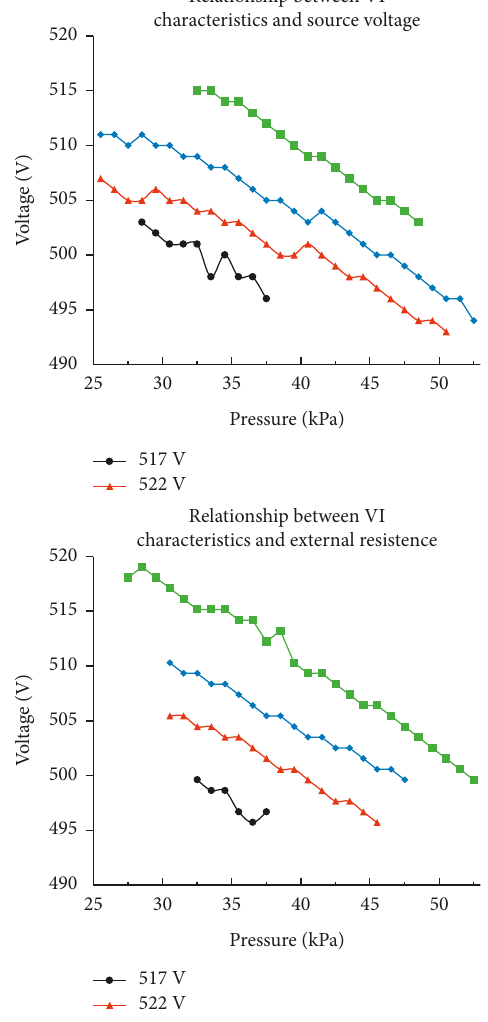
Figure 9: Relationship between characteristic curve and source voltage and external voltage. (a) Relationship between VI char- acteristics and source voltage. (b) Relationship between VI char- acteristics and external Figure 9 reflects the VI characteristics of a 50 μ m